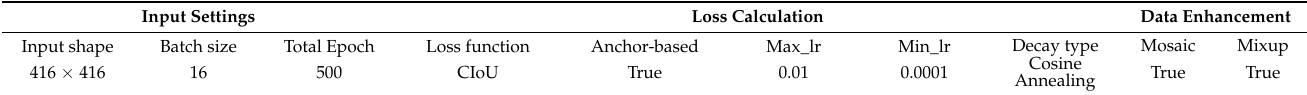
Table 7. The hyperparameters set during the training of the proposed method.